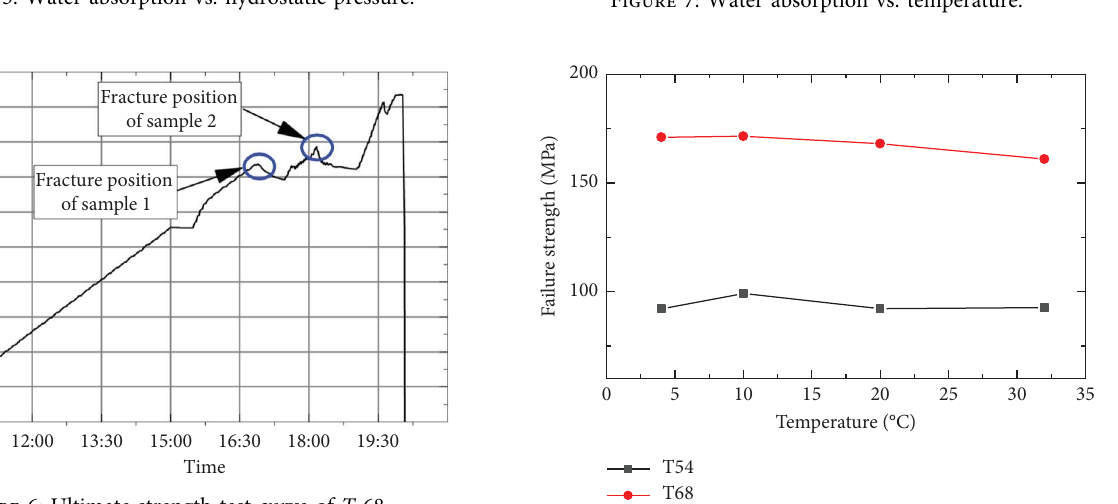
Figure 5: Water absorption vs. hydrostatic pressure.